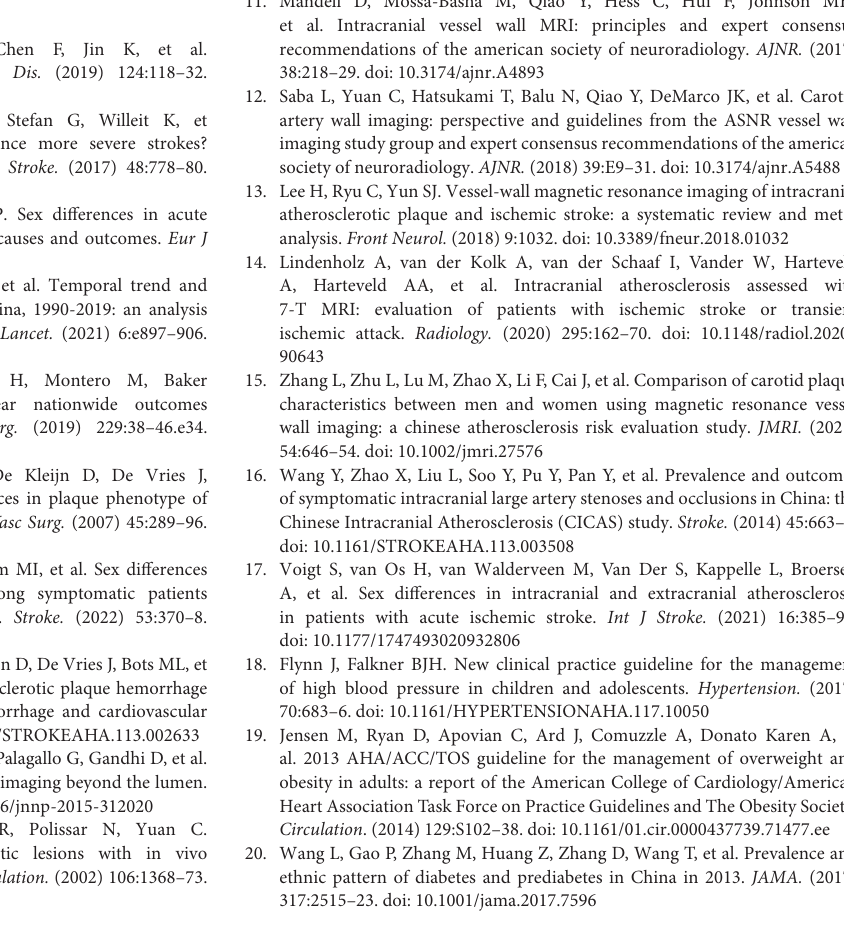
Supplementary Figure S1 | Flow chart of patient recruitment for final analysis. Supplementary Table S1 | Sex differences in the reference sites of intracranial